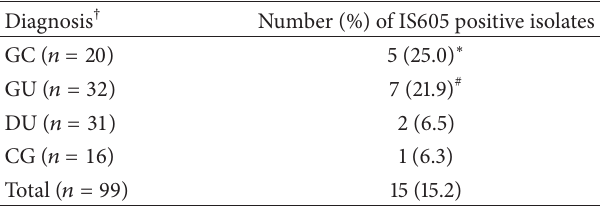
Table 3: Prevalence of IS605 in H. pylori isolated from patients with gastric carcinoma, gastric ulcer, duodenal ulcer, and chronic